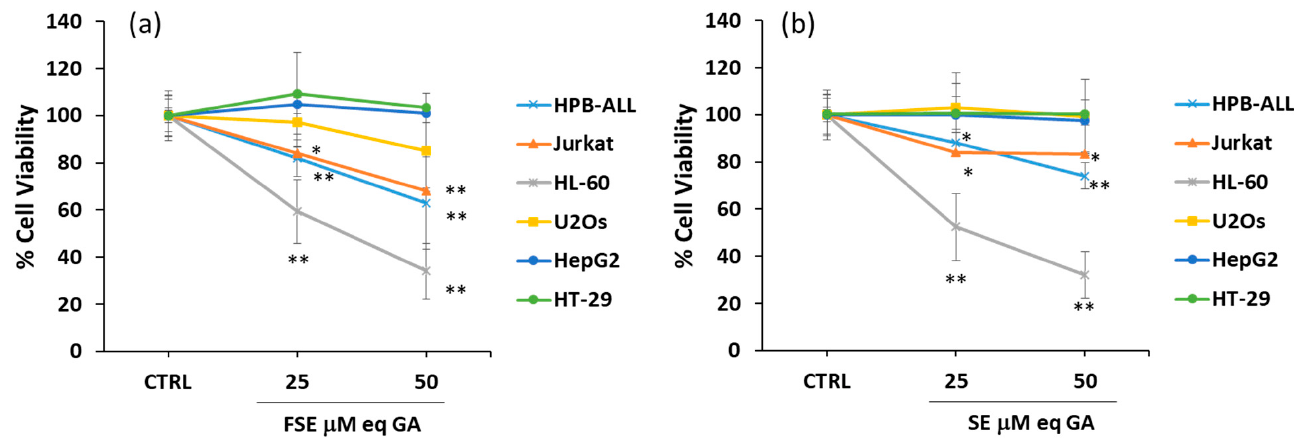
Figure 3. FSE effect on cell viability in different cell lines. HPB-ALL, Jurkat, HL-60, U2Os, HepG2, HT-29 cell lines were treated for 24 h with ( a ) FSE and ( b ) SE at the indicated concentrations. Cell viability was assessed using a crystal violet and CyQuant assay as reported in Materials and Methods section. Bar graphs represent the mean of three experiments ( ± SD). Symbols indicate significance: p < 0.05 (*) and p < 0.005 (**) respect to control (CTRL) (DMSO treated cells).